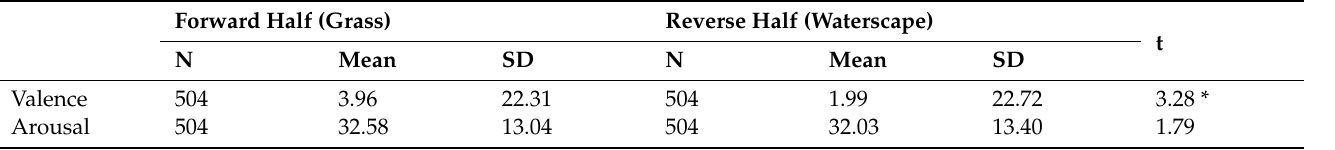
Table A1. Descriptive statistics and paired t-test results of perception data for different element compositions of similar